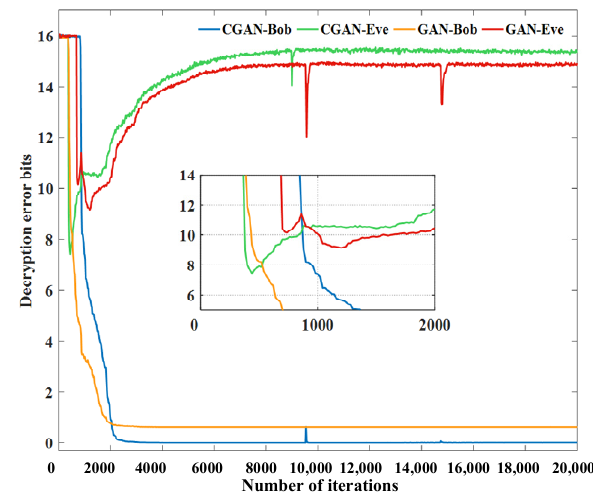
Remote Sens. 2023 , 15 , x FOR PEER REVIEW Figure 12. Comparison of training results in 32-bit scenarios. Figure 12. Comparison of training results in 32-bit scenarios.